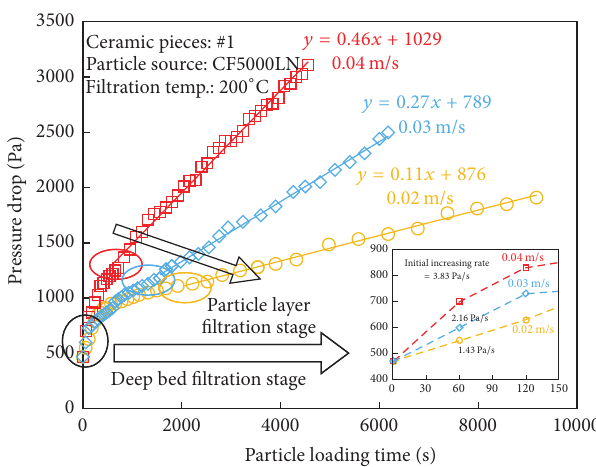
Figure 6: Pressure drop for different filtration velocities (in order to conveniently compare the increment rates of the pressure drop for different filtration velocities, the initial pressure drops are set to the same value of 470 Pa which is measured for the 0.02 m/s filtration